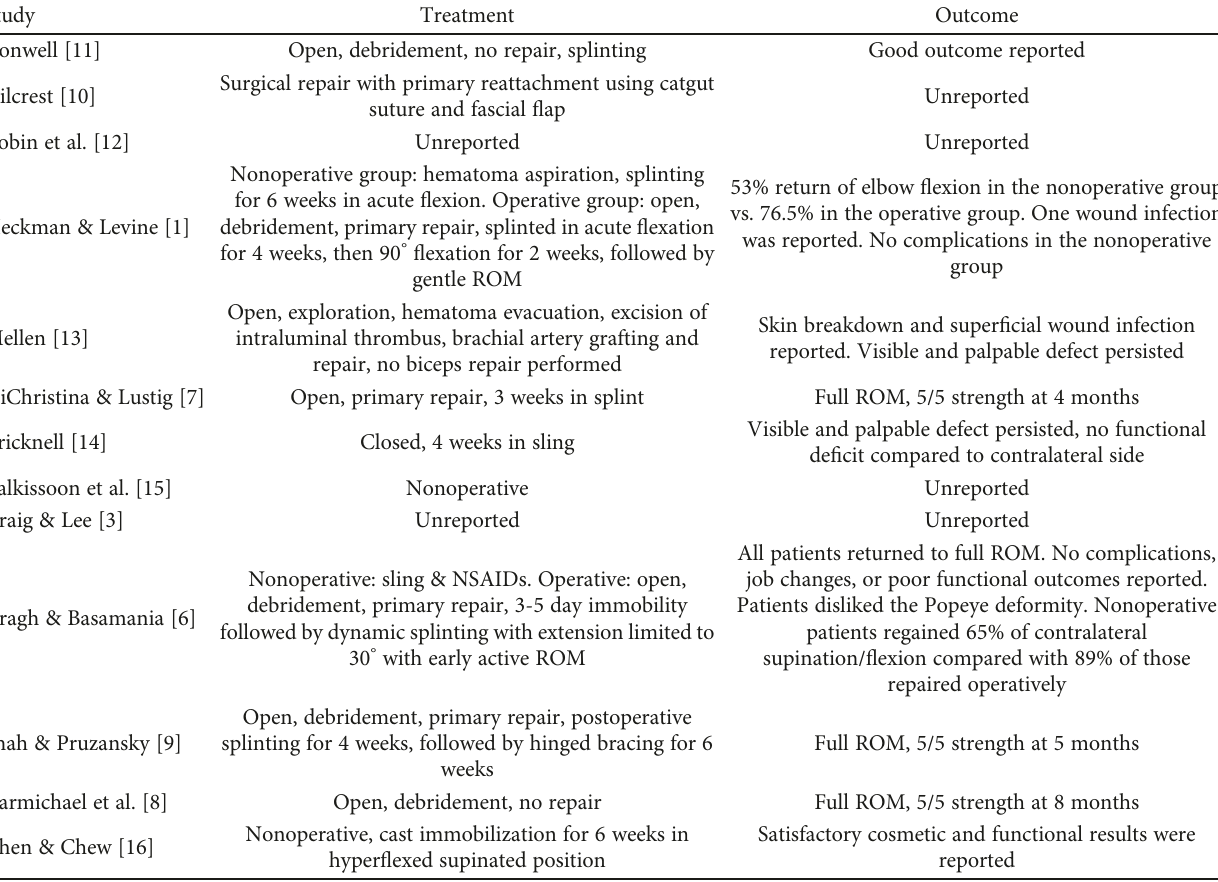
Table 1: The table demonstrates the published studies regarding the traumatic intrasubstance rupture of the biceps brachii, the type of treatment, and their